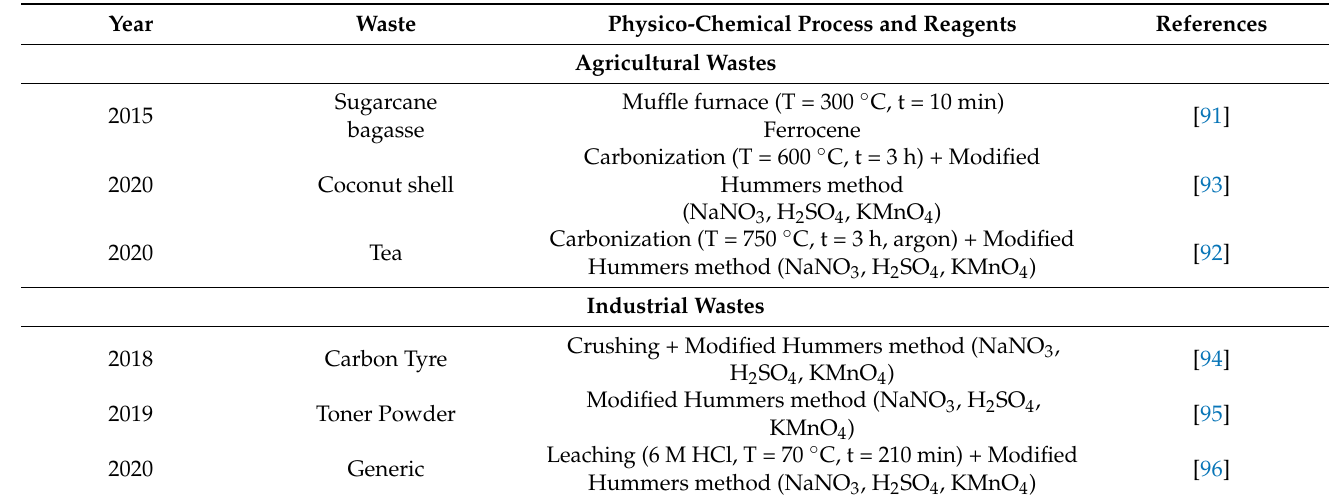
Table 3. List of GO preparation approaches from agricultural and industrial